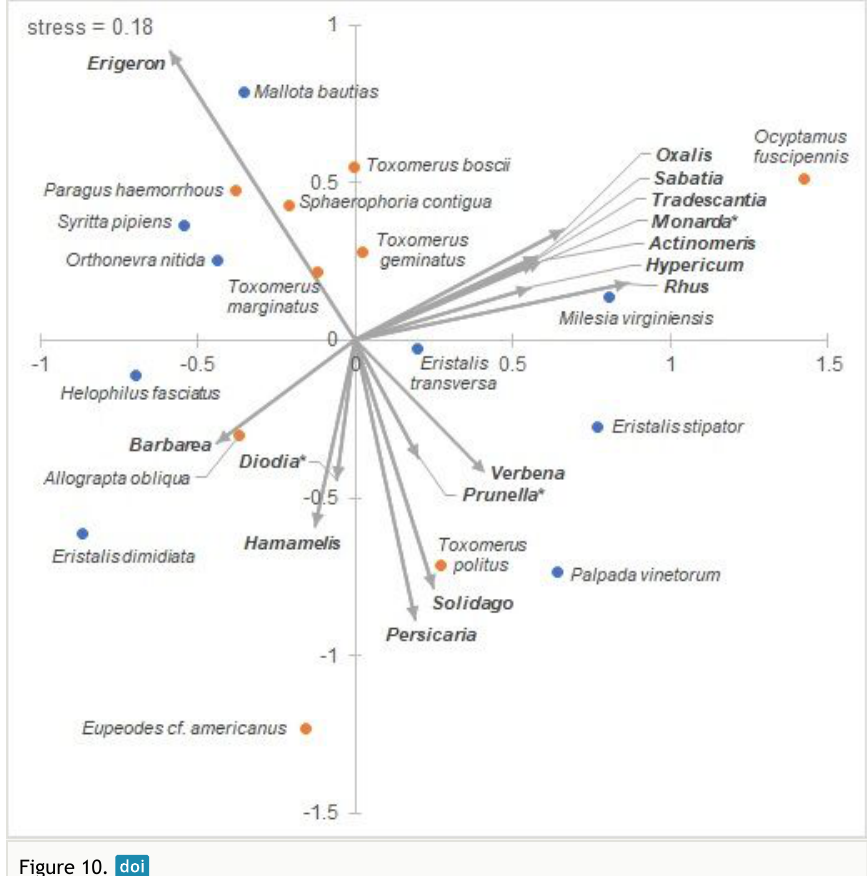
NMDS ordination of 18 syrphid species by floral association genera. Blue points represent species in subfamily Eristalinae, orange points Syrphinae. Significant (alpha=0.1) plant vectors are shown. Plant genera names followed by an asterisk have p<0.1; all others have